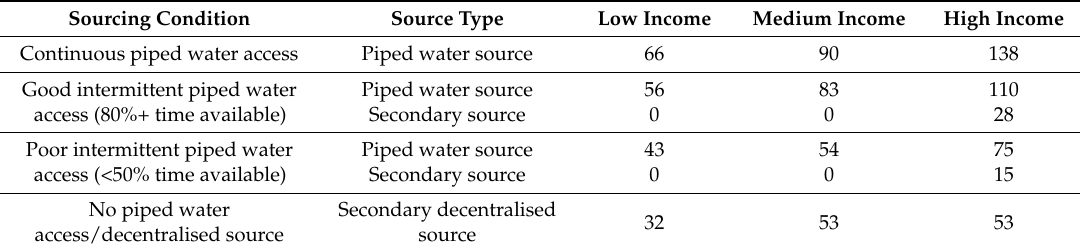
Table 3. Water consumption in litres per capita per day by income, sourcing condition and source type. Source of data: